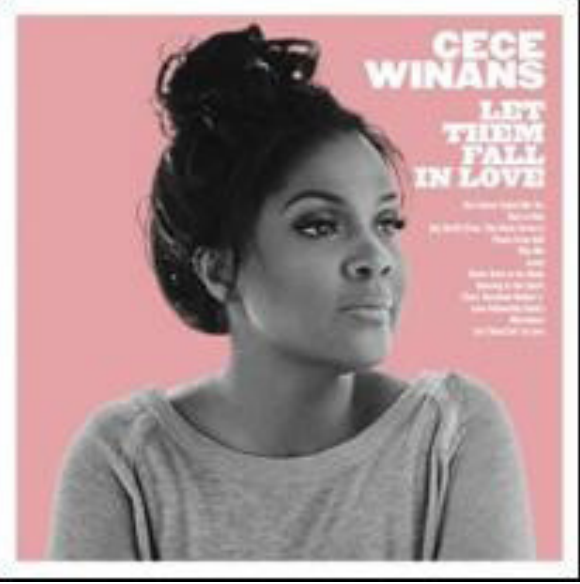
Figure 3. Winans’ Let Them Fall in Love album